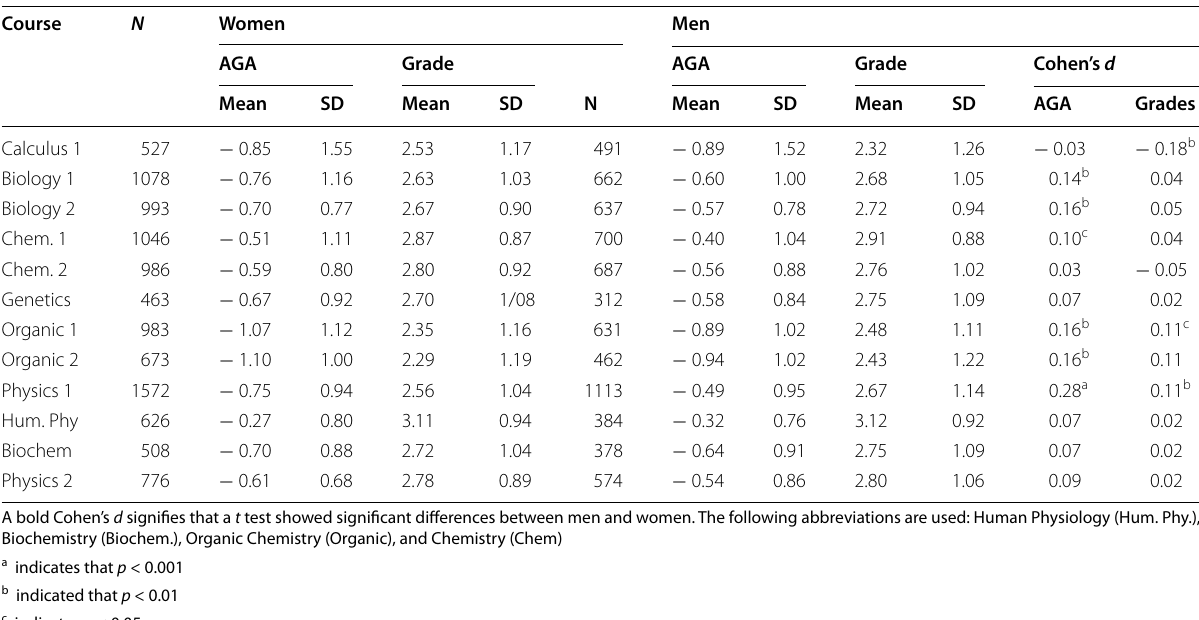
Table 4 Average grade anomalies (AGAs), grades, and between-gender effect sizes for each course of interest